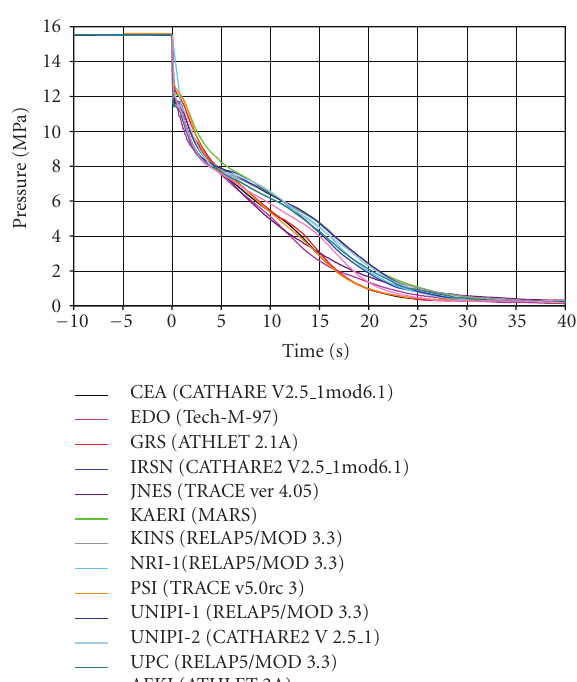
Figure 5: Time trends of intact loop 1 pressure in hot leg.